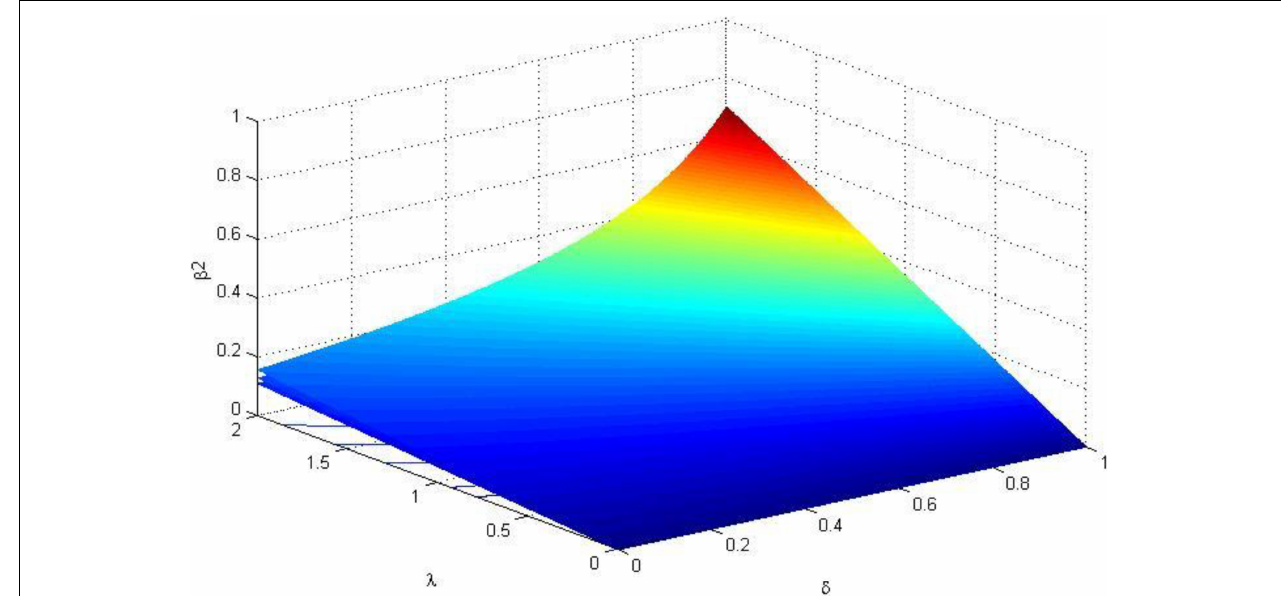
FIGURE 3 | The trend of the incentive coefficient of the second-ranked worker β 2 ( σ 2 = 0 . 8).